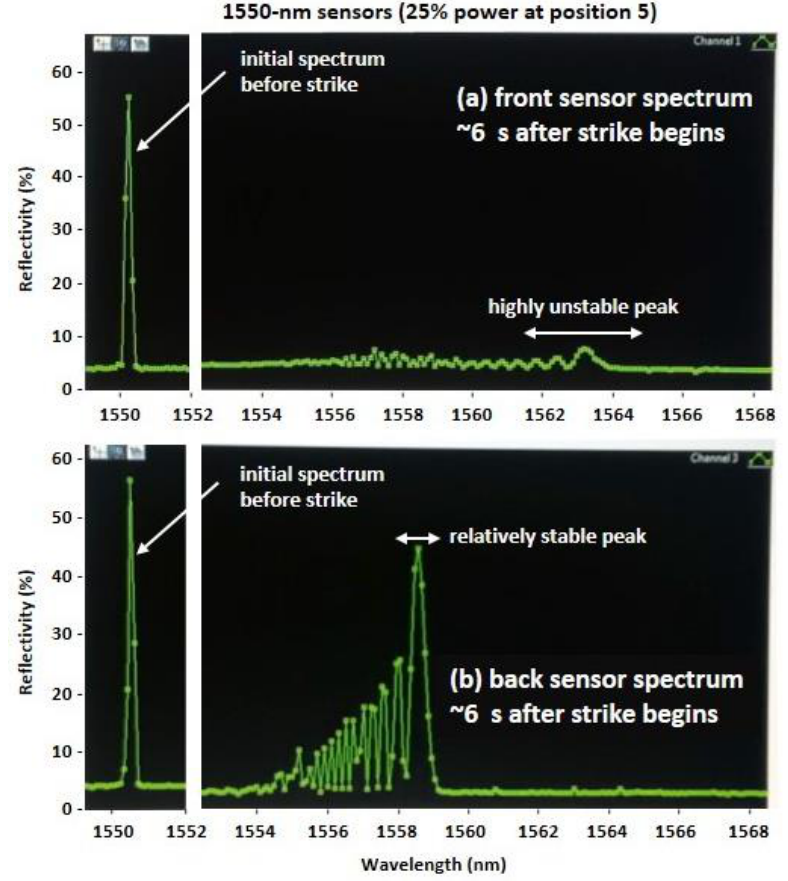
  nm, nominally) for B